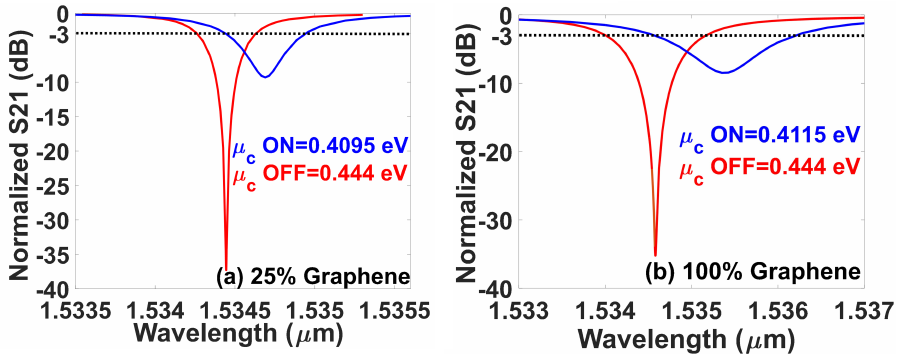
Figure 4. The modulator’s transmission curves versus the wavelength considering both OFF (red) and ON (blue) states and different percentages of graphene. ( a ) At 25% graphene and ( b ) 100%